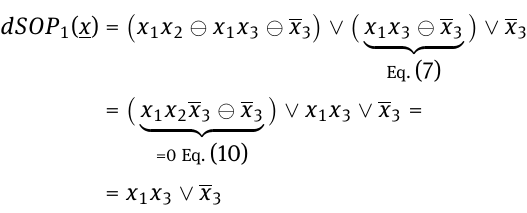
(Figure 3). The coverage of 1s is done by two cubes. By sort- ing, a minimized dSOP can be reached. The comparison of the three functions shows their equivalence. They are